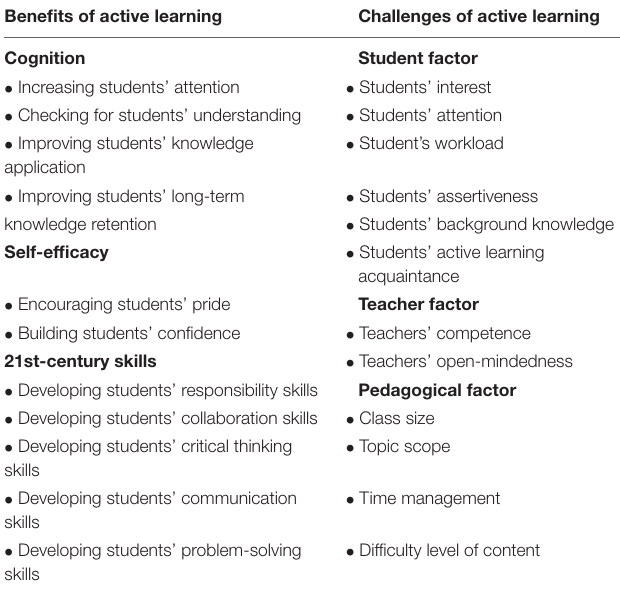
TABLE 1 | Results of deductive thematic analysis and items in quantitative